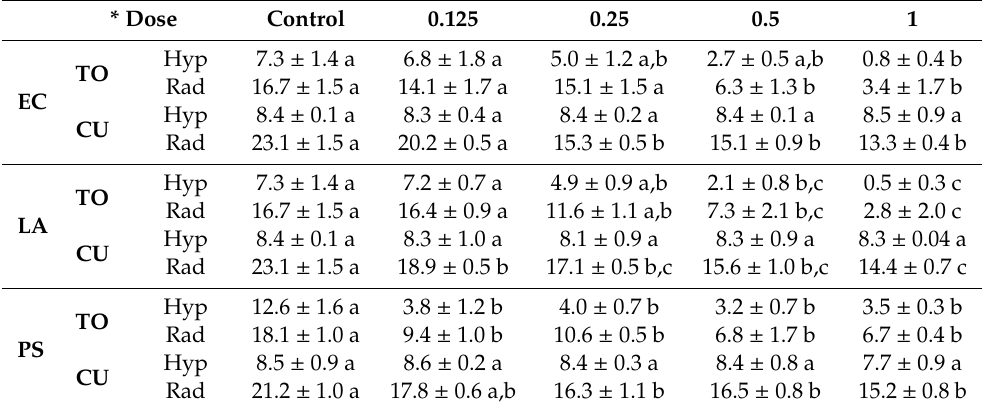
Table 4. In vitro phytotoxic e ff ect of di ff erent doses of E. citriodora (EC), L. angustifolia (LA), and P. sylvestris (PS) essential oils on tomato (TO) and cucumber (CU) seedling growth.